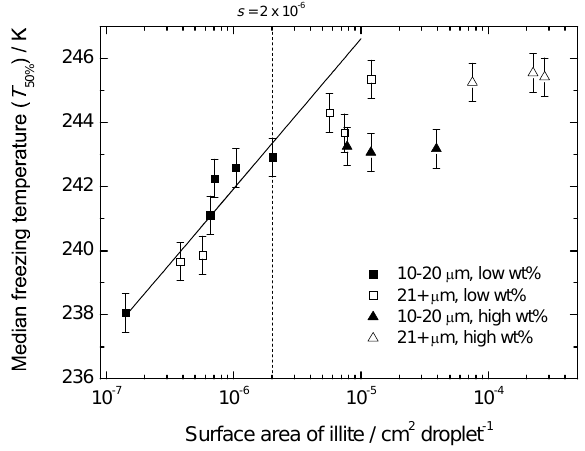
Fig. 4. The median freezing temperature ( T 50% ) as a function of NX illite surface area and droplet size for experimental runs 1–9. These runs were all performed using a cooling rate of 5Kmin − 1 (see Table 1 for details). For simplicity we have divided the data according to concentration and droplet size. Low wt% is defined as ≤ 0.15wt%; high wt% data points are for wt% ≥ 0.63wt%. The dashed vertical line marks the surface area ( s) chosen as the upper limit to the low surface area regime (see text). Also shown is the best fit to the data in the low surface area regime (solid